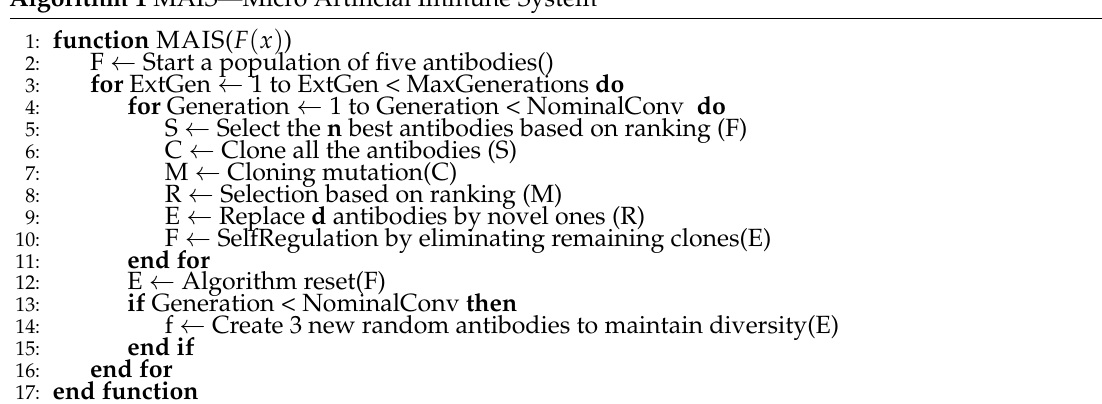
Algorithm 1 MAIS—Micro Artificial Immune